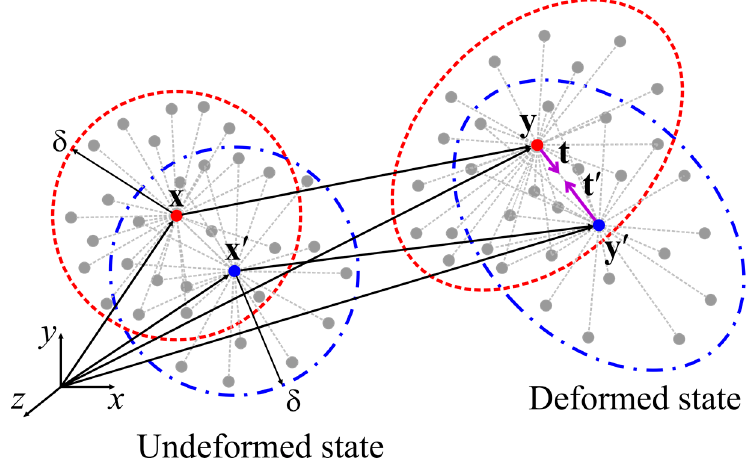
Figure 1. The horizon of the material points located at x and x (cid:48) and the peridynamic forces between them in ordinary state-based peridynamics.